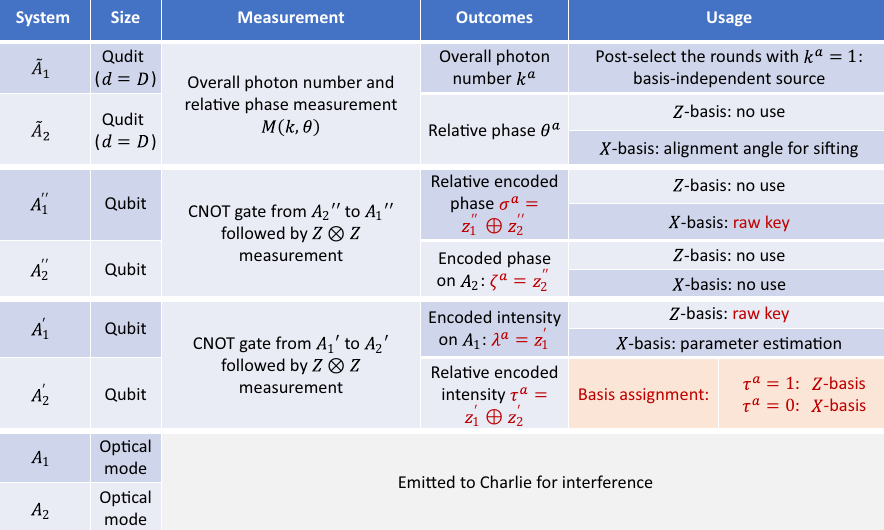
and A 0 are 1 2